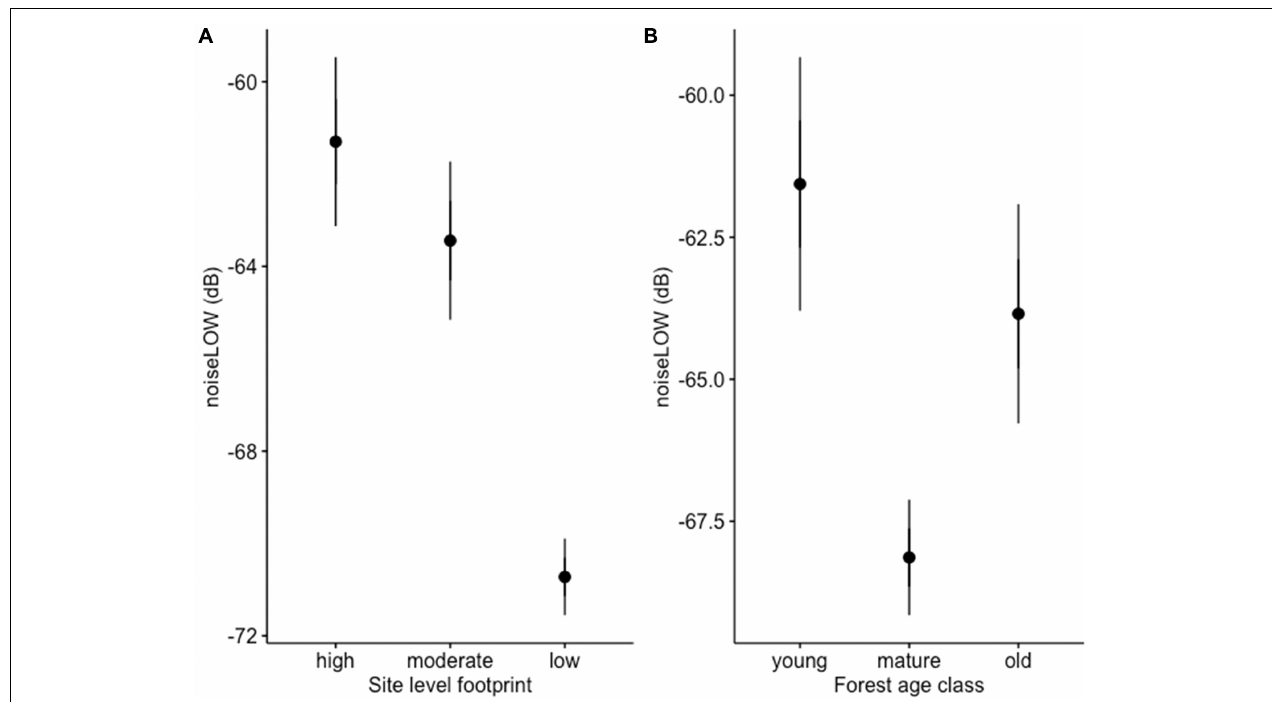
FIGURE 2 | (A) Predicted noise level for noiseLOW at the high, intermediate, and low footprint sites. (B) Predicted average noise levels for noiseLOW in young, mature, and old forest ARU locations. Error bars are 95% CI.